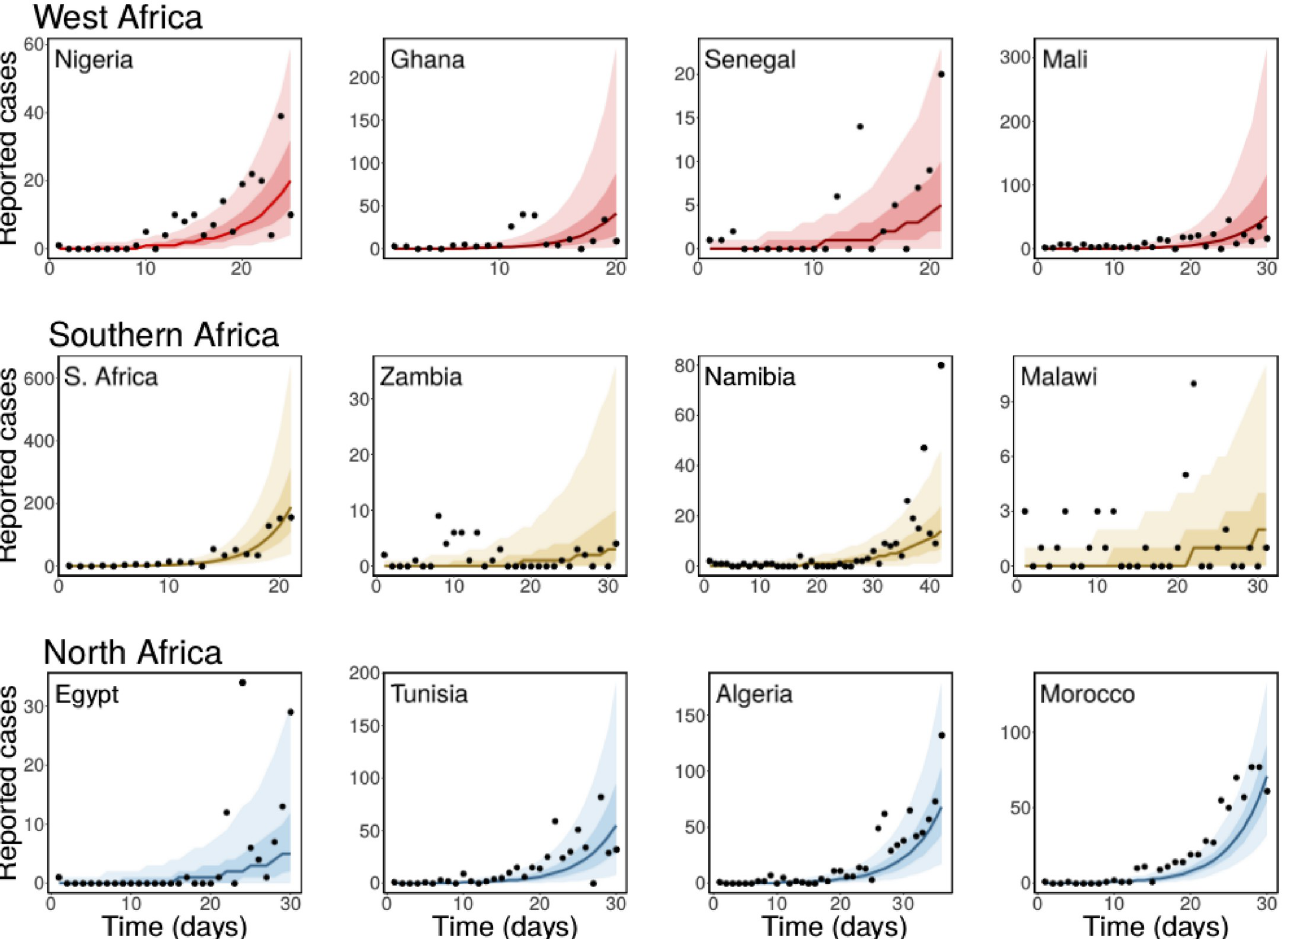
Fig 1. Observed and estimated number of daily cases of COVID-19. Top panel: West Africa (Nigeria, Ghana, Senegal and Mali), middle panel: Southern Africa (South Africa, Zambia, Namibia and Malawi), and bottom panel: North Africa (Egypt, Tunisia, Algeria and Morocco). The black dots are the daily reported cases of COVID-19, the solid lines are the median predicted cases, the narrower (darker) bands are the 50% CrI, while the wider (lighter) bands are the 90% CrI.